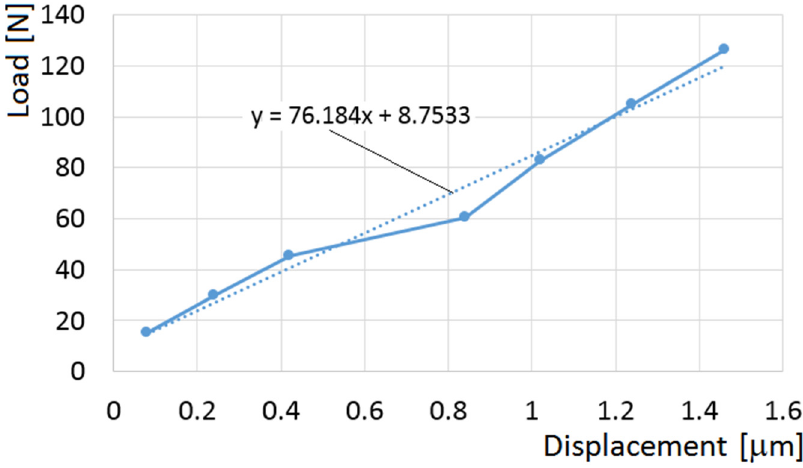
Figure 10. Static stiffness characteristic at position 5 in the run in +X direction. Appl. Sci. 201 8 , 8 , 15